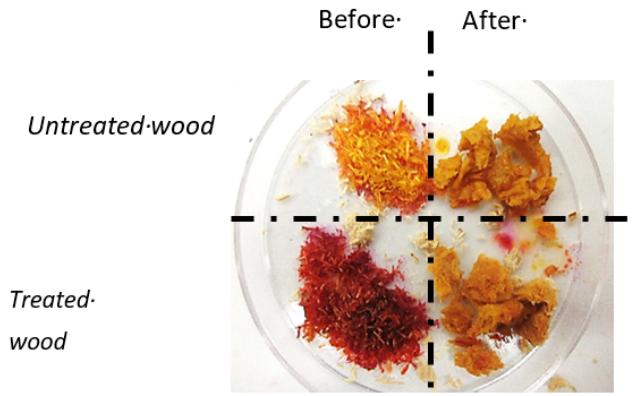
Figure 5. Colorimetric copper with (Pyridyl-2-azo)-1-naphthol-2 (PAN) in milled wood sample before or after bioprocessing treatment. The loss of wood stain shows the decontamination of copper from wood by microorganisms.